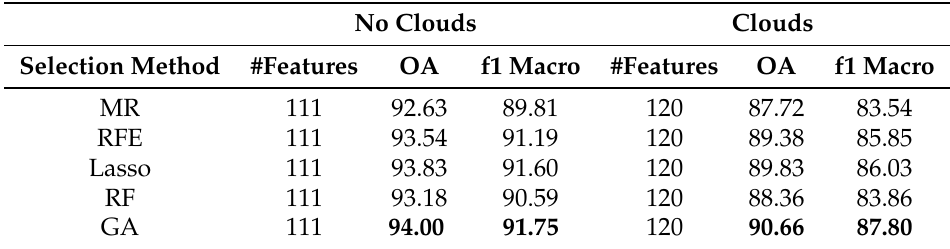
Table 6. Performance of the different feature selection methods. Bold indicates the methods with which the best results are